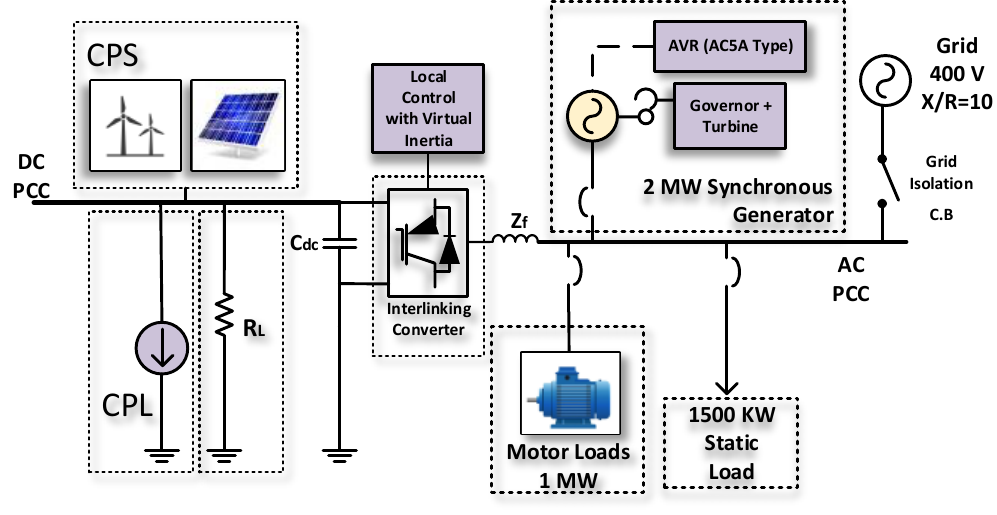
Figure 1. Microgrid system under